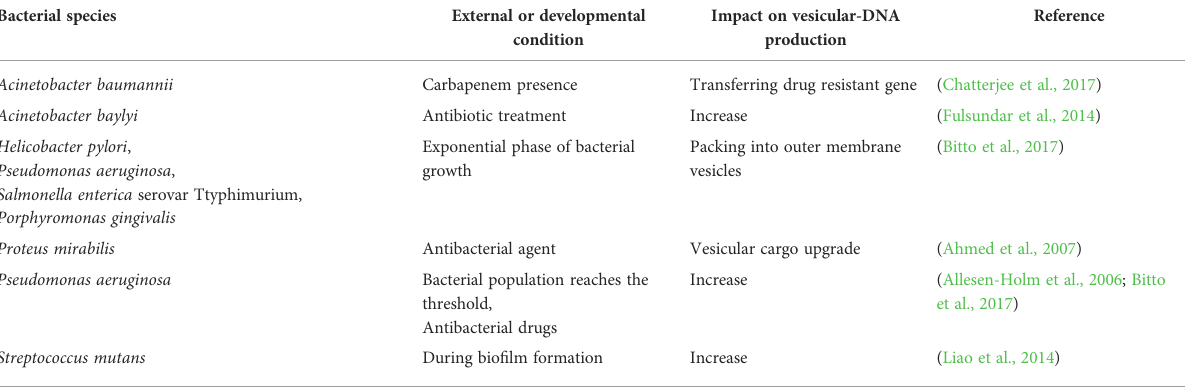
TABLE 2 External and developmental conditions impacting the production of vesicular-DNA by certain bacterial species. Bacterial